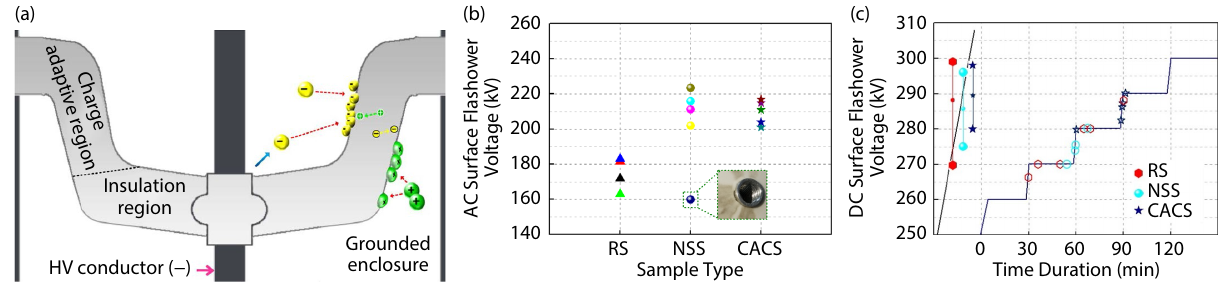
Fig. 6 A novel HVDC spacer based on SADs. ( a ) The structure of the spacer and the space charge migration (reprinted with permission from ref. [98], © 2018 IEEE). ( b ) AC surface flashover test results of experimental samples (reprinted with permission from ref. [99], © 2018 IEEE). ( c ) DC surface flashover test results of ex- perimental samples (reprinted with permission from ref. [99], © 2018